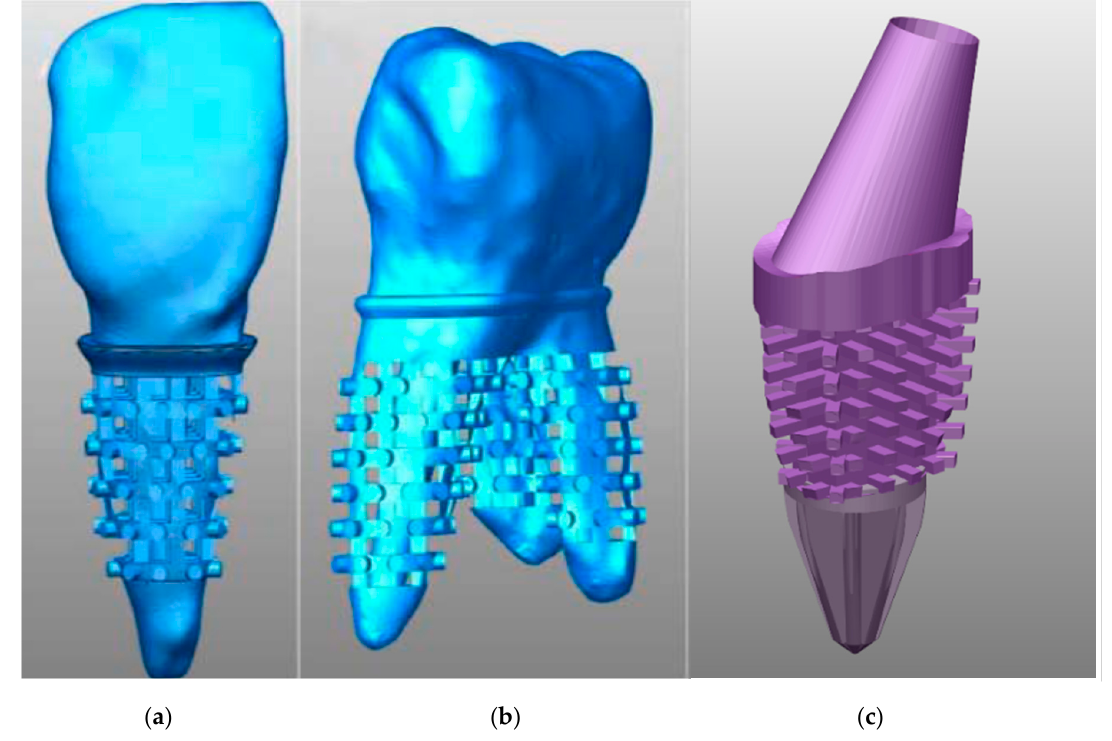
Figure 23. Examples of implant-scaffolds ( a , b ) with a porous structure and ( c ) with protrusions on the surface.